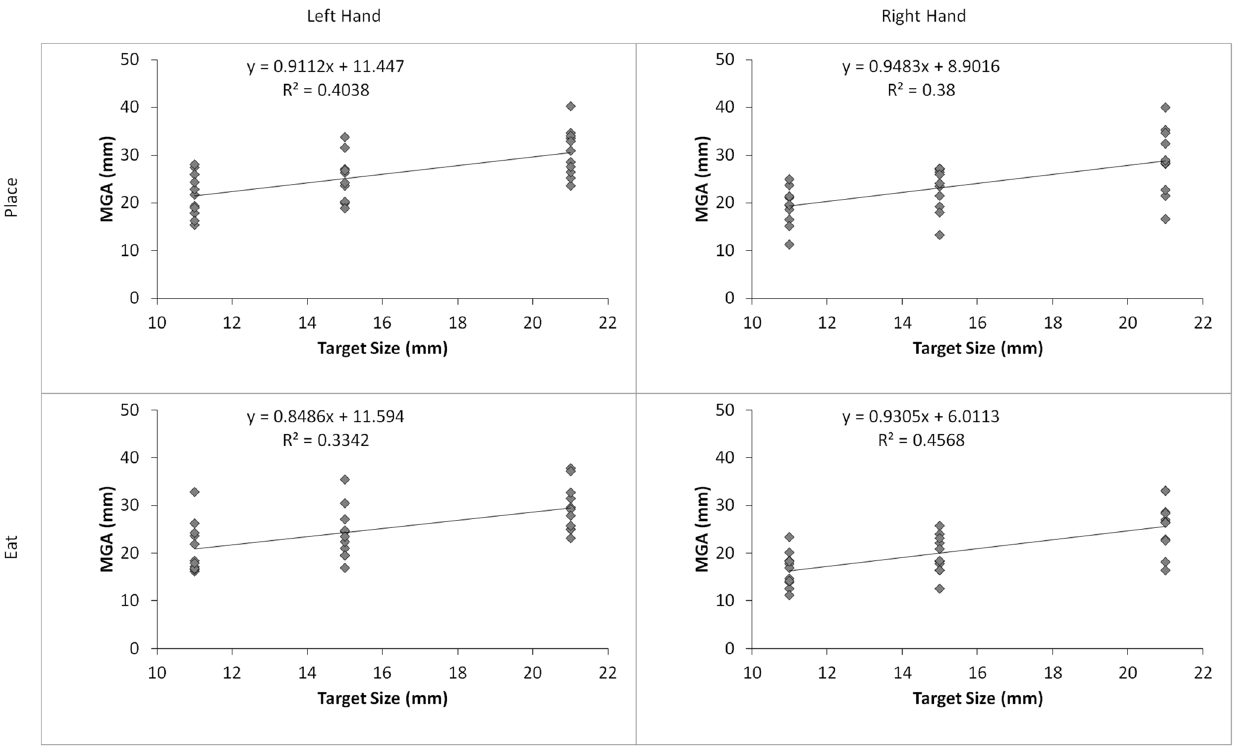
Figure 4. MGA and slope for all Hand 6 Task conditions. Slopes between conditions were not significantly different.